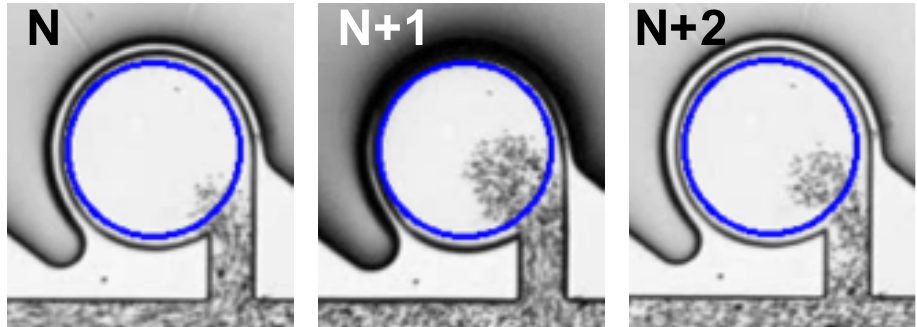
Figure A6. N-th to N + 2nd frame of an experiments. Main chamber repeatedly expanded and contracted, which caused rattling luminance